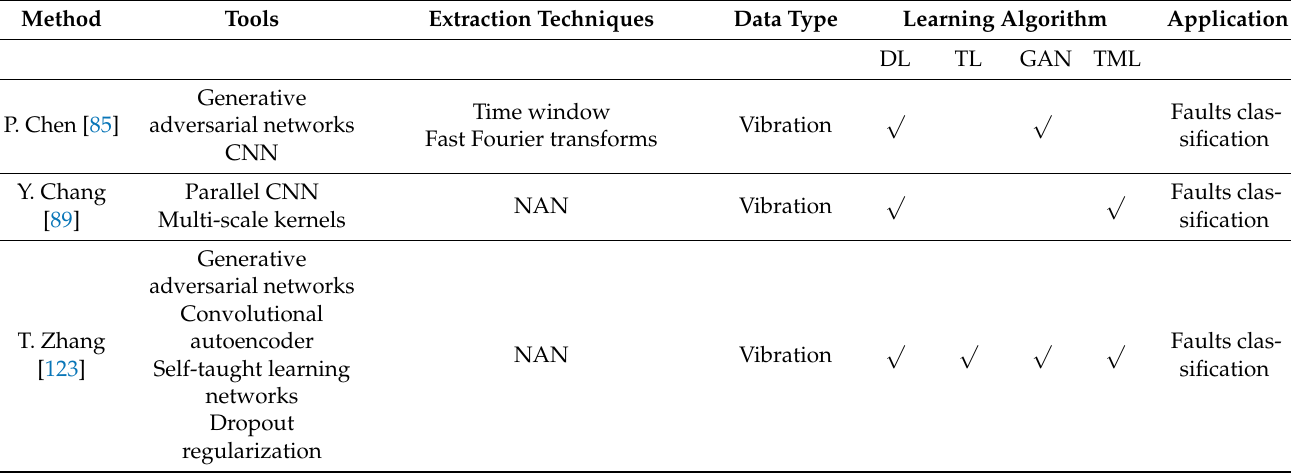
Table 5. Generator condition monitoring state of the art